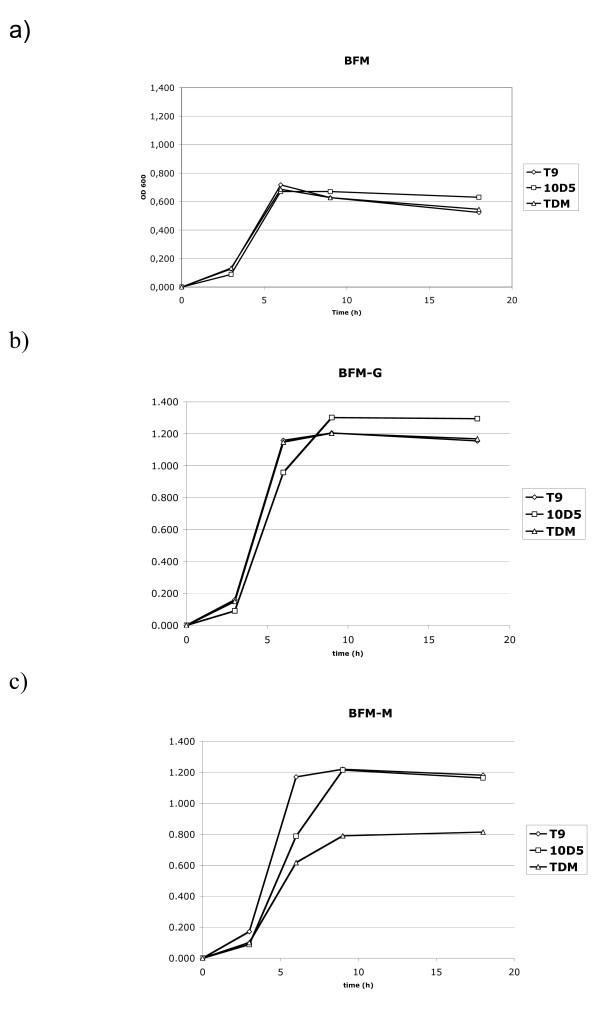
Growth curves of E. faecalis T9 (diamonds), 10D5 (squares), and TDM (triangles) in BFM (a), BFM-G (b), and BFM-M (c). The OD595 after 18 h of incubation was comparable for the different strains in medium without additional sugars and in medium supplemented with 1% glucose. The wild-type strain and the transposon mutant grew equally well in medium containing 1% maltose, while the triple deletion mutant grew significantly less.